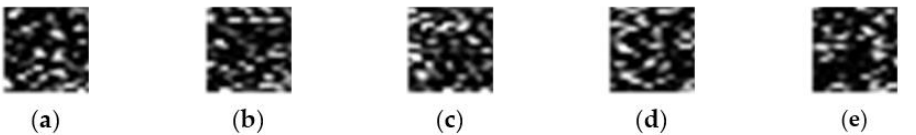
Figure 12. Partial 20 × 20 sample graph without target under the condition of 0 dB SNR, and the units are ( a ) 1000th, ( b ) 2000th, ( c ) 3000th, ( d ) 4500th, and ( e ) 6000th. Figure 11. Partial 20 × 20 sample graph with target under the condition of 0 dB SNR, and the target in unit positions are ( a ) 0.8, ( b ) 0.65, ( c ) 0.5, ( d ) 0.3, and ( e ) 0.15.